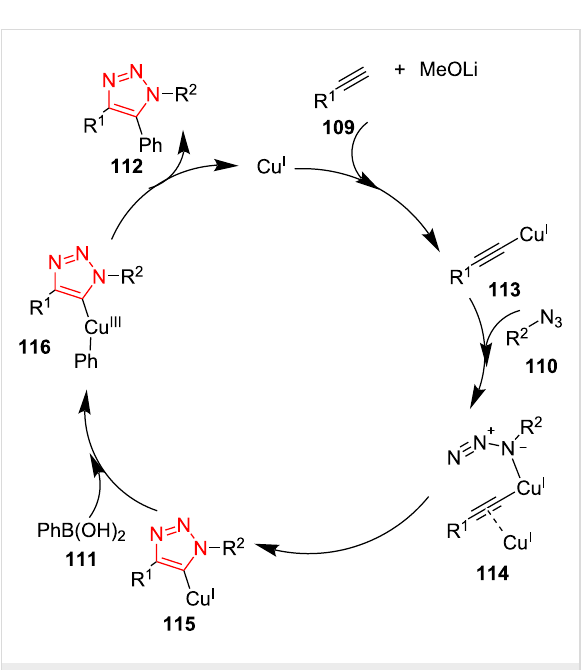
Scheme 34: A reasonable mechanism for the synthesis of 5-aryl- substituted 1,2,3-triazole derivatives 112 .